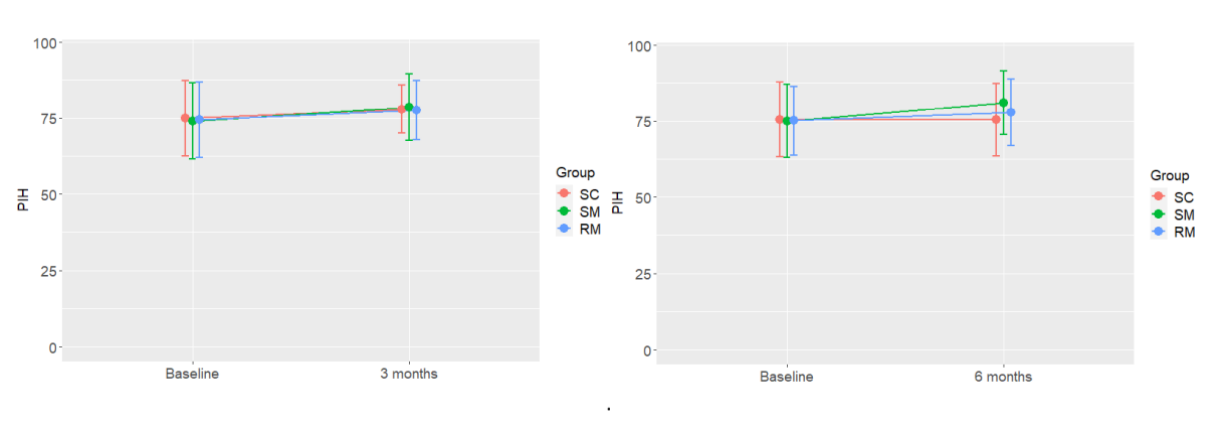
Figure 2. PIH at baseline and 3 months and baseline and 6 months for each group. Significant improvement in PIH scores from baseline to 3 months ( P =.001) and from baseline to 6 months ( P =.008) were observed, but no group effects or interactions, suggesting no differential effect among the groups. PIH: Partners in Health; RM: remote monitoring SC: standard care; SM: